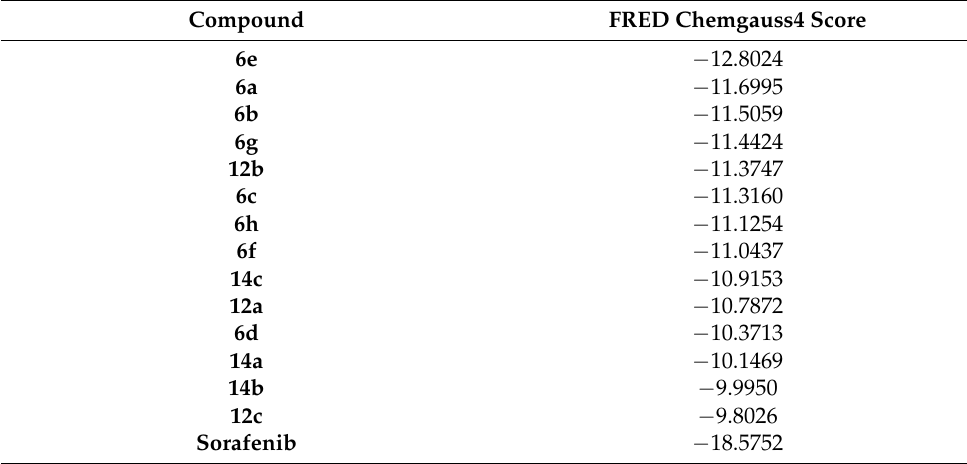
Table 3. FRED Chemgauss4 scores of target compounds 6a – h , 12a – c , and 14a – c